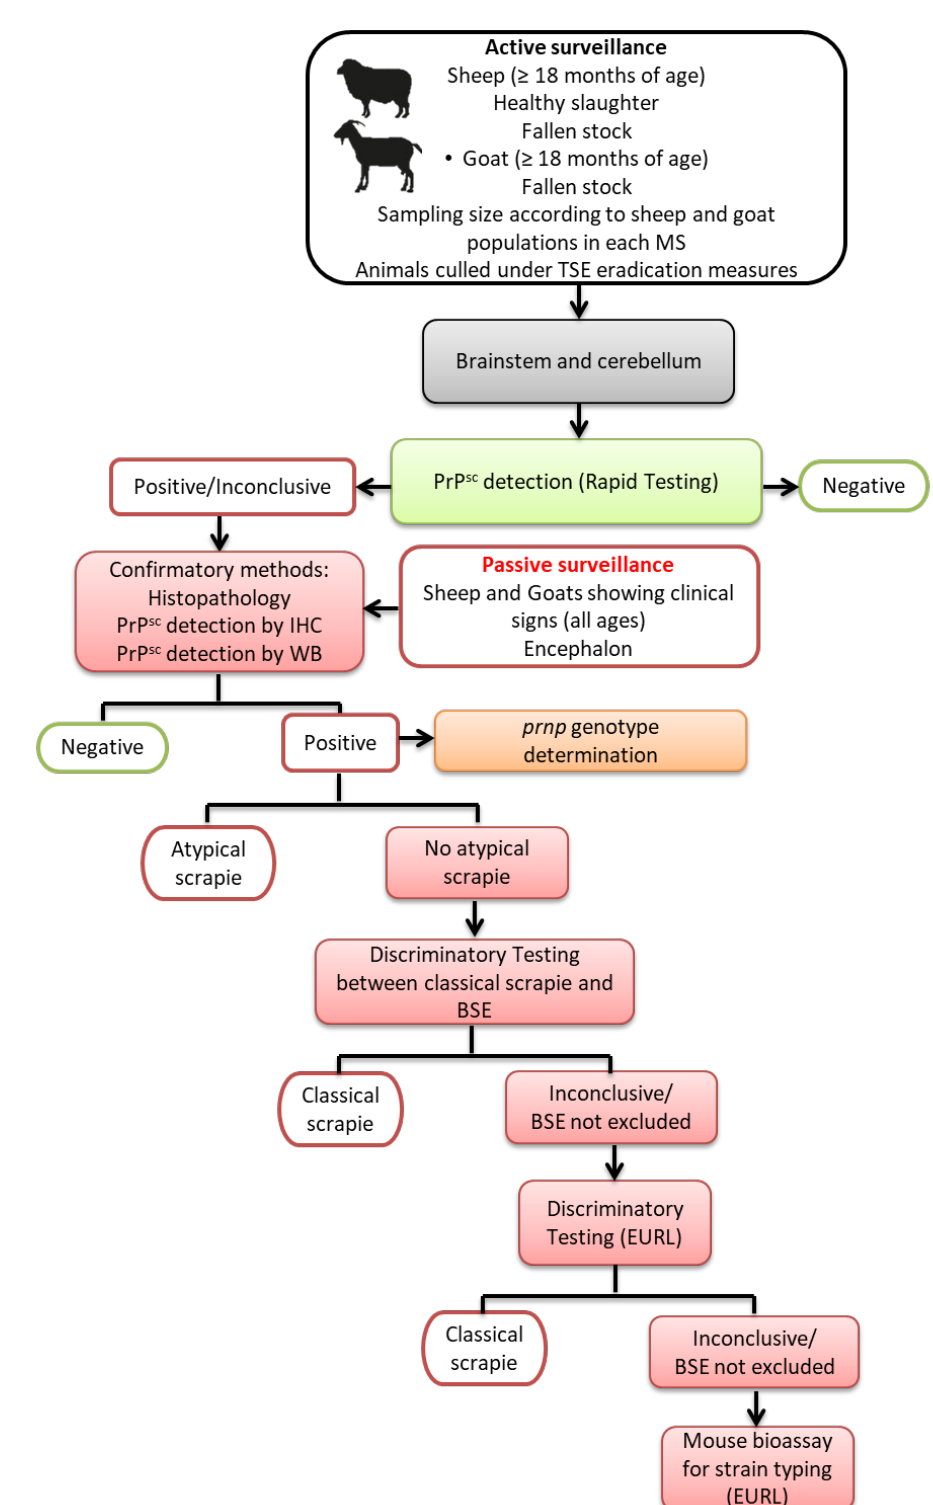
Figure 1. Sampling and diagnostic procedures in European Union TSE surveillance for small ruminants (MS—member state; IHC—immunohistochemistry; WB—Western Immunoblot; EURL—European Reference Laboratory for animal